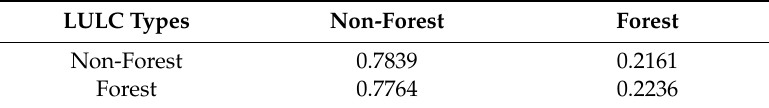
Table 8. Markov transition probability matrix of simulated LULC map